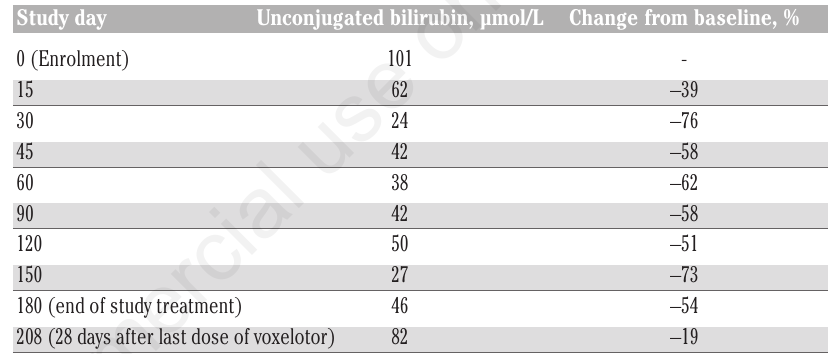
Table 1. Unconjugated bilirubin and change from baseline over time with voxelotor treat- ment.